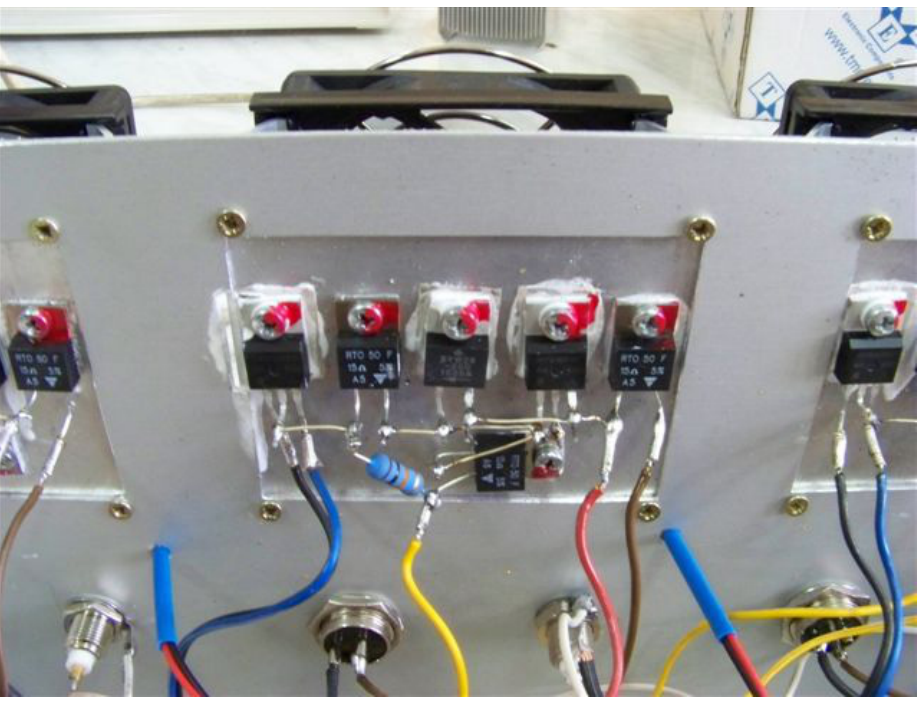
Figure 2. The heat sink with the resistors.